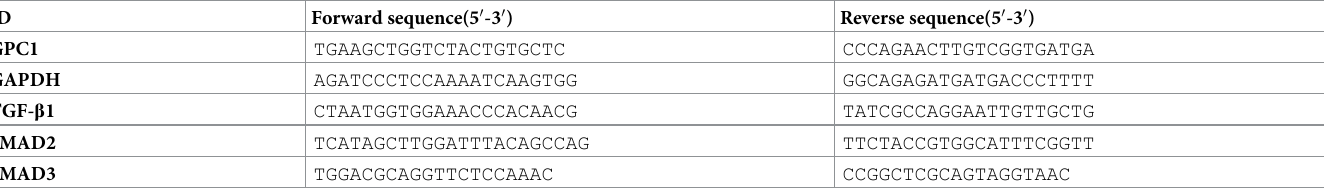
Table 1. Sequences of primers for